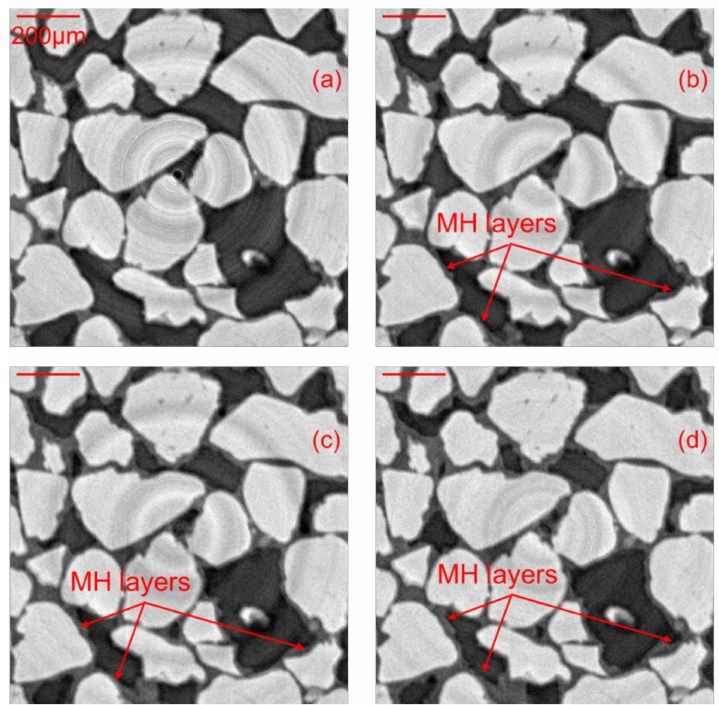
Figure 9. Tomographic sections of the thickening of methane hydrate (MH) layers in run 3 ( a ) 4 h following imposition of the MH formation conditions, ( b ) 10 h, ( c ) 15 h, and ( d ) 21 h.